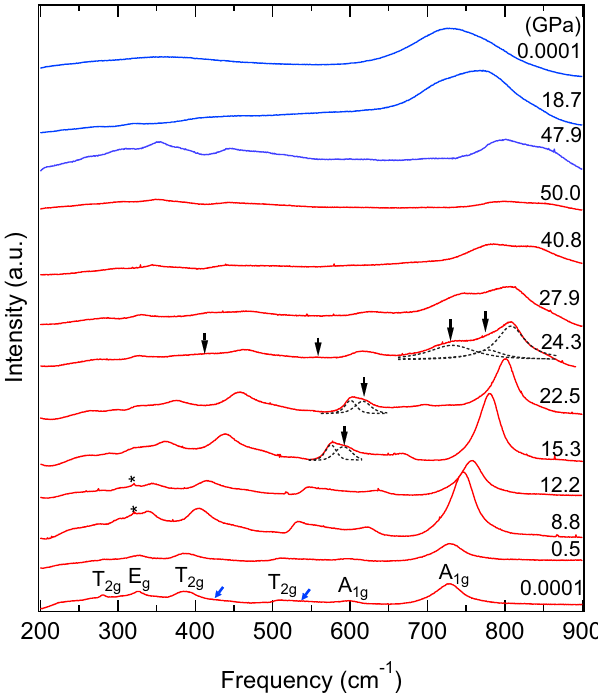
Figure 2. Raman spectra of Mg 2 TiO 4 at pressure to 50.0 GPa and room temperature. A new Raman mode appeared at 15.3 GPa and four new peaks appeared at 24.3 GPa. Red: compression, blue: decompression, asterisk symbols ( * ) only observed at 8.8 and 12.2 GPa are MgTiO 3 . Blue arrows are the shoulders of Mg 2 TiO 4 Raman modes. Blue and black arrows indicate the Raman modes of spinel and tetragonal phases,